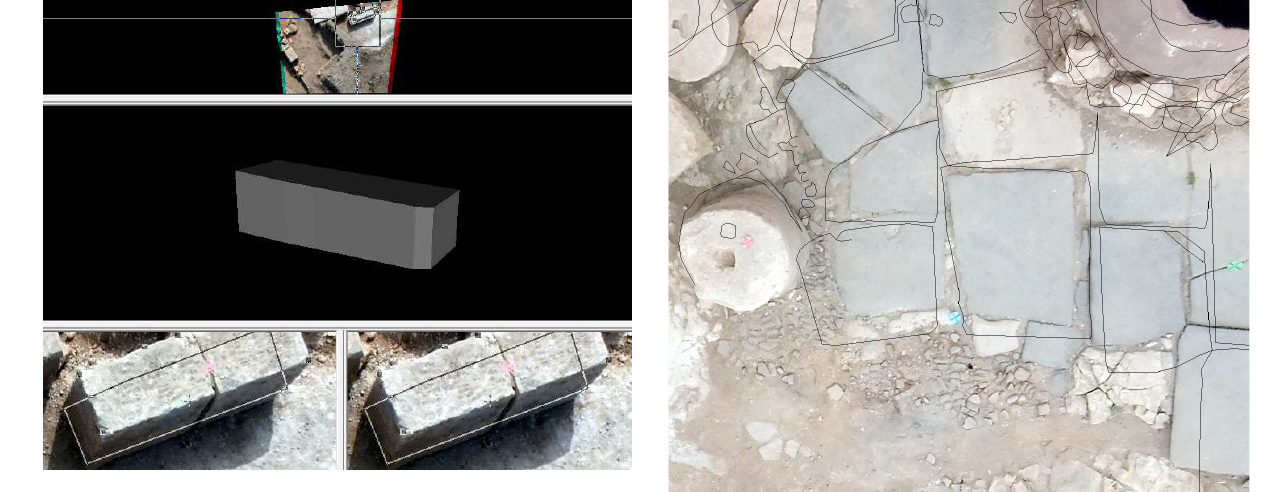
Figure 5. 3D measurement and extraction of an ashlar rock from UAV-based anaglyph 3D images at Doliche (ERDAS Stereo Analyst)